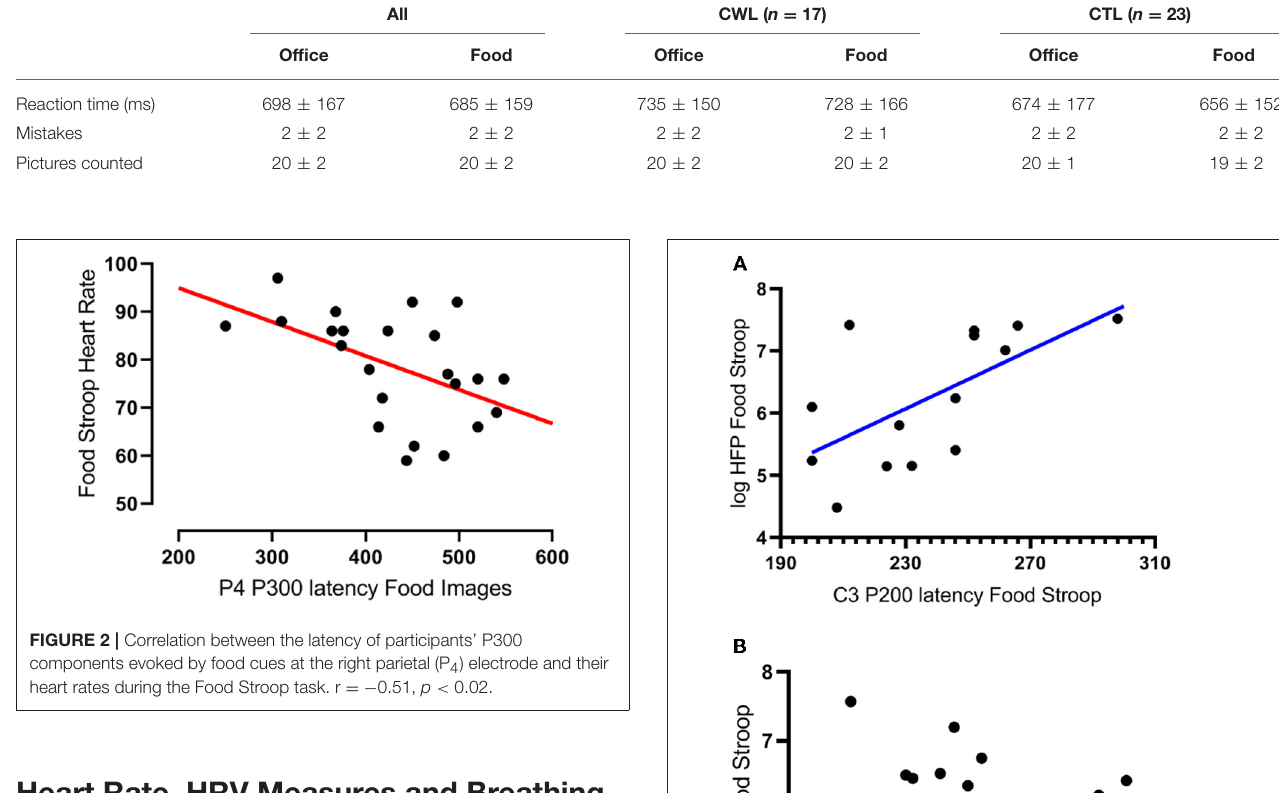
TABLE 2 | Office and Food Stroop task reaction times, mistakes made and images counted: CWL vs. CTL groups. All